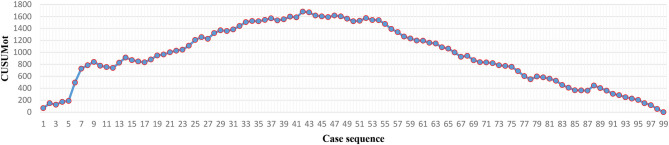
Cumulative sum graph for operative time for Prof. Yao.